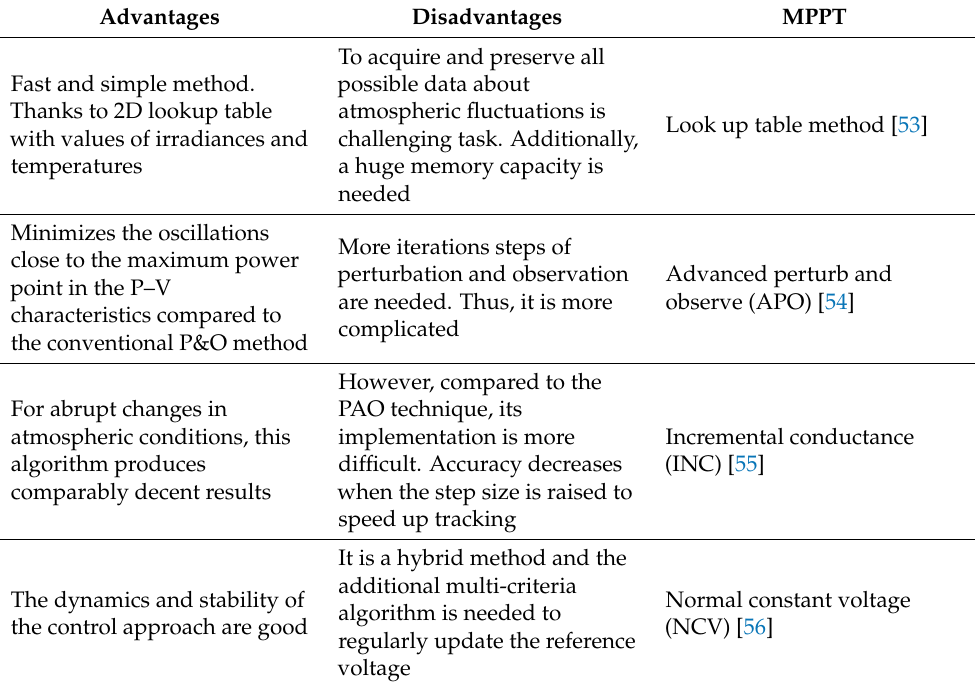
Table 6. Advantages and disadvantages of MPPT